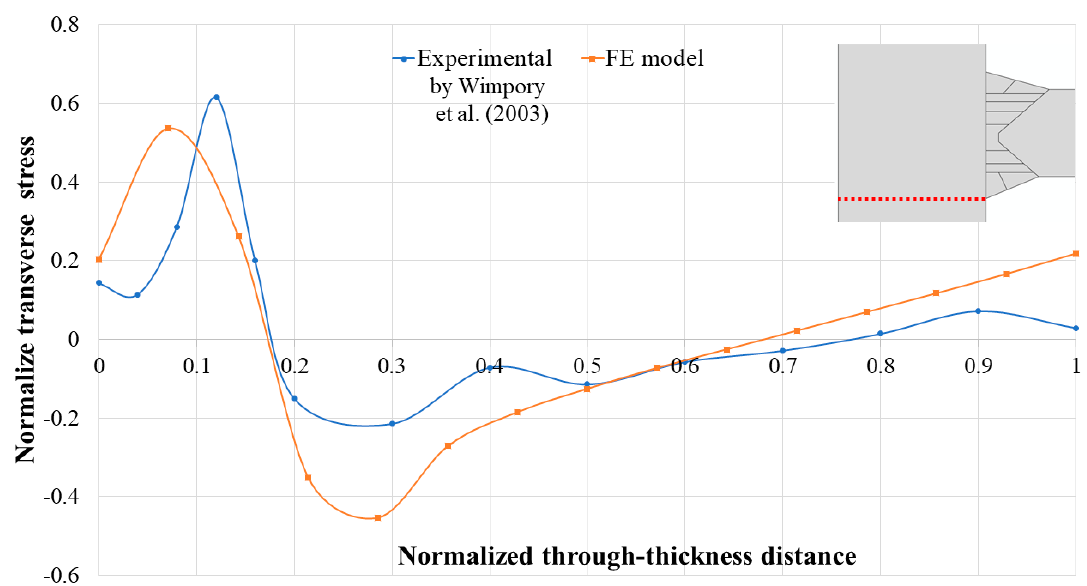
Figure 6. Comparison between experimental and FE Figure 6 . Comparison between experimental and FE results.